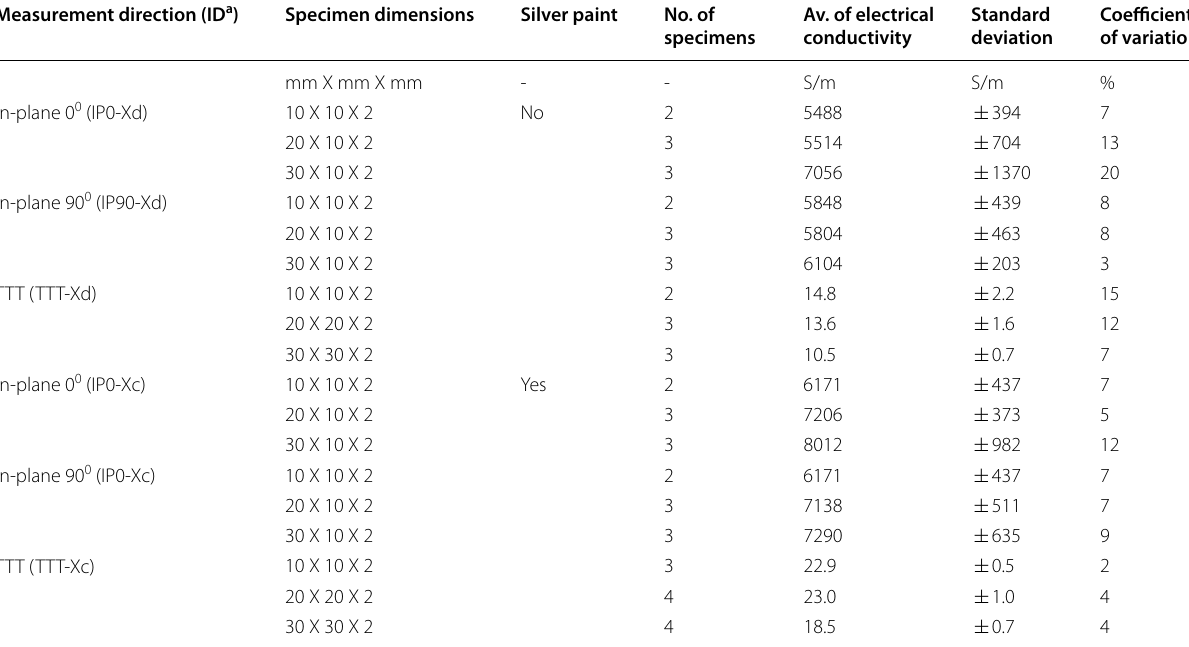
a IP0 and IP90 denote in-plane 0 0 and 90 0 directions, respectively, TTT through the thickness direction; X takes 1–2 for 10 mm long specimens, 3–5 for 20 mm long specimens, and 6–8 for 30 mm long specimens; c for painted and d for unpainted specimens